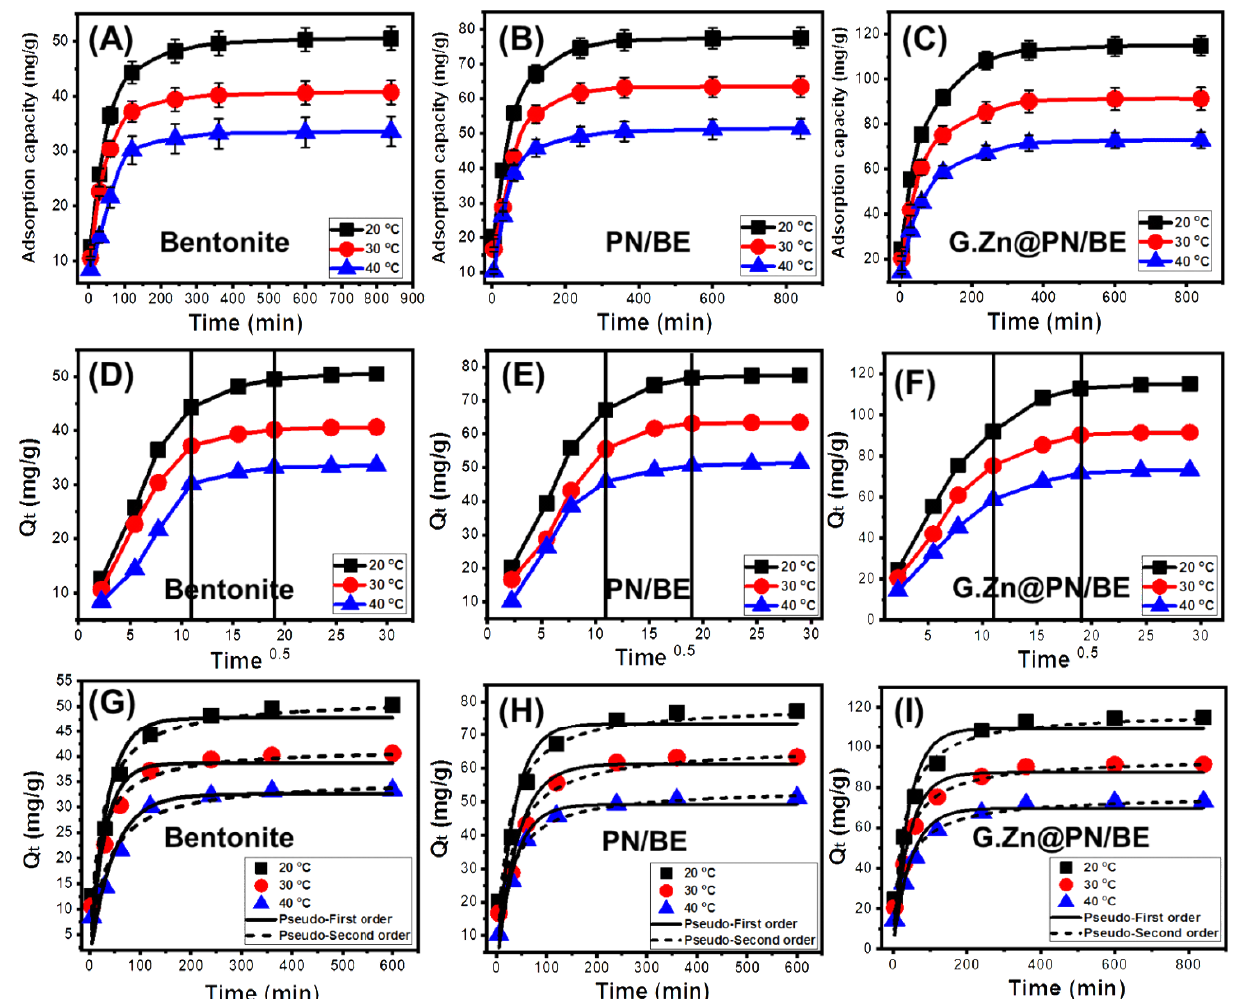
Figure 5. The retention behavior of As (V) ions by BE, PN/BE, and G.Zn@PN/BE as function of time ( A – C ), the Intra-Particle diffusion curves of As (V) adsorption results ( D – F ), and fitting of the As (V) retention results with the different kinetic models ( G – I ).